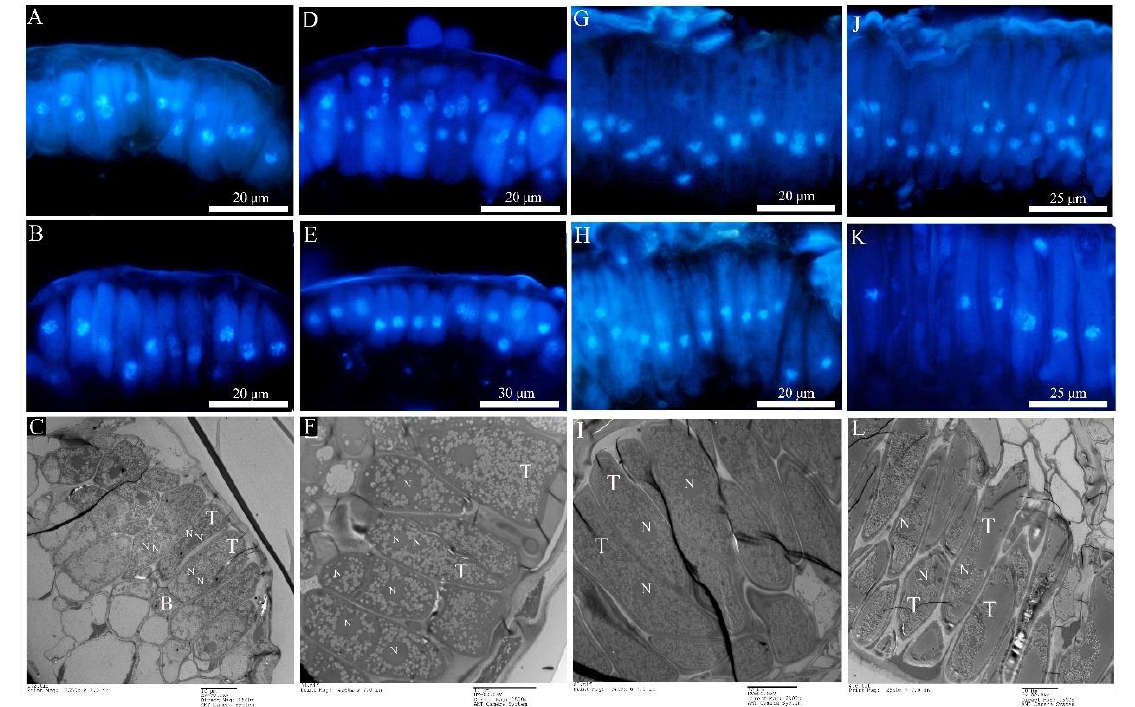
Figure 6. Teliospora under fluorescence microcopy and transmission electron microscopy. ( A – C ): Mlp ; ( D – F ): Mmed ; ( G – I ): Mmag ; ( J – L ): Mpr ; ( A , D , G , J ) refer to dikaryotic teliospore; ( B , E , H , K ) refer to the fusion and mononucleate (diploid) teliospore; ( C , F , I , L ) refer to teliospore under TEM; teliospore (T); basel cell (B); nuclei (N).